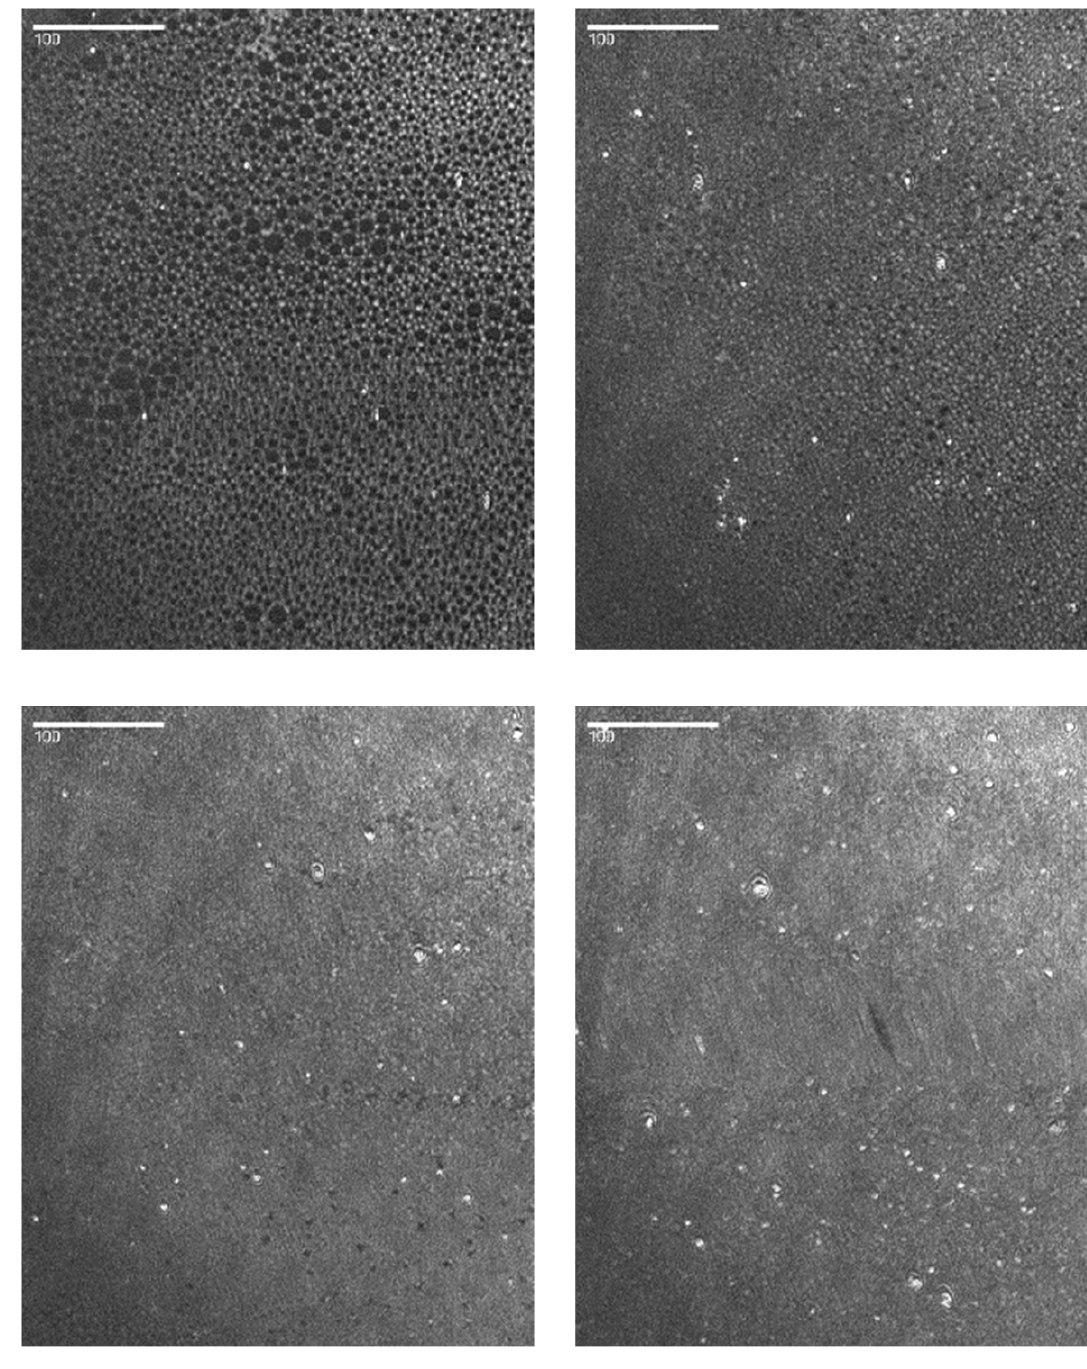
Figure 3. BAM images of a GCB monolayer on water at various surface pressures—scale bar represents 100 μm; top left, top right, bottom left, bottom right: 1, 5, 10, 25 mN m −1 .